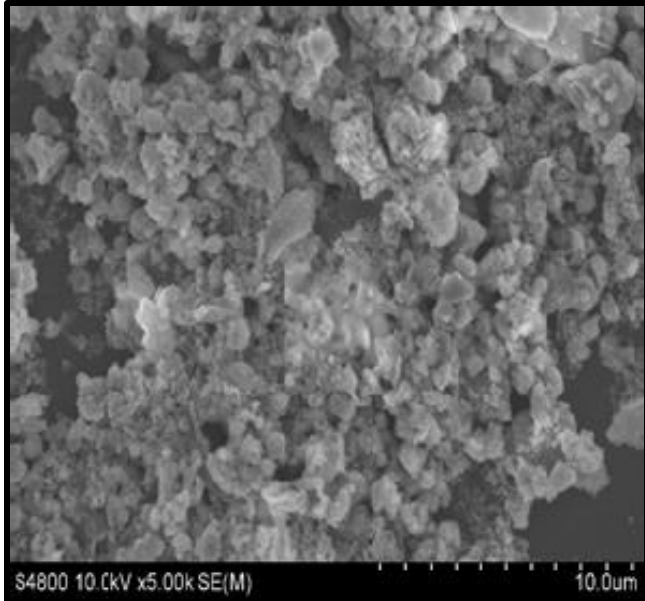
Figure 6. SEM micrographic image of mycosynthesized ZnO NPs.